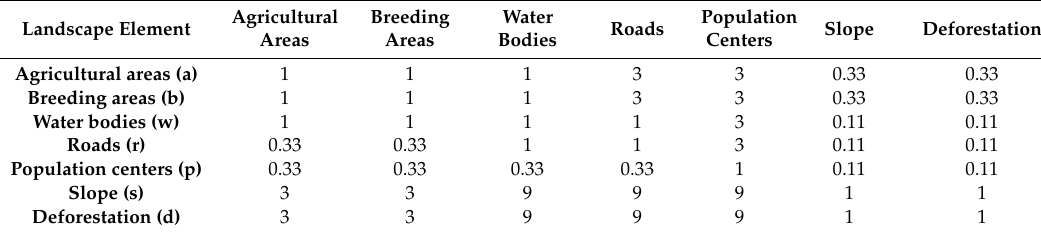
Table 3. Comparison matrix of the criteria for the determination of the deforestation hazards.